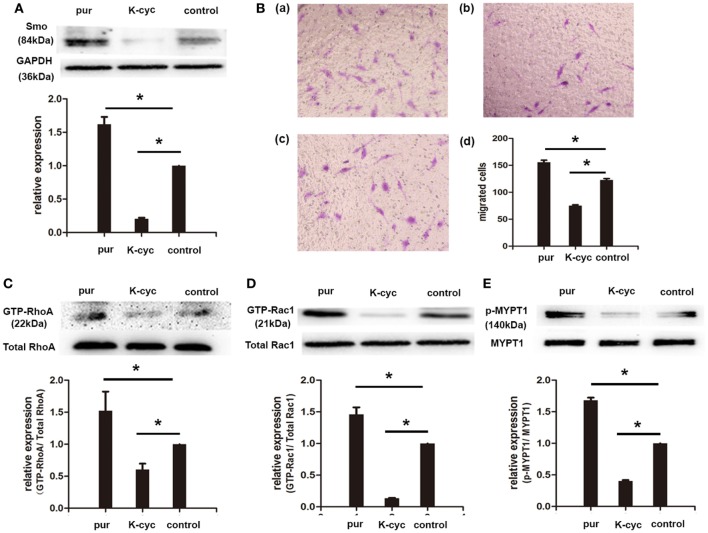
Smo agonist and antagonist regulated rheumatoid arthritis (RA)-fibroblast-like synoviocytes (FLSs) migration and RhoGTPase signaling. RA-FLSs were cultured for 24 h before incubation with Smo agonist (purmorphamine, 5 μmol/l) or Smo antagonist (KAAD-cyclopamine, 1 μmol/l) for 24 h. The effects of purmorphamine and KAAD-cyclopamine on the expression of Smo were measured by Western Blot analysis, and Smo expression was evaluated and normalized to GAPDH (A). Cell migration was evaluated using Transwell assays and the numbers of migrated cells were calculated (×104 cells/ml) [(B), d]. Representative images of RA-FLSs migration after treatments with purmorphamine [(B), a], KAAD-cyclopamine [(B), b], or vehicle [(B), c] were displayed (100 magnifications). The activation of RhoA and Rac1 was detected by pull-down assays (C,D). Expression of MYPT1 was detected by Western Blot analysis and the levels of phospho-MYPT1 were normalized to expression of total MYPT1 (E). The results are the mean ± SD of three independent experiments. *P < 0.05 versus control group. pur, purmorphamine; K-cyc, KAAD-cyclopamine; MYPT1, myosin phosphatase targeting subunit 1.